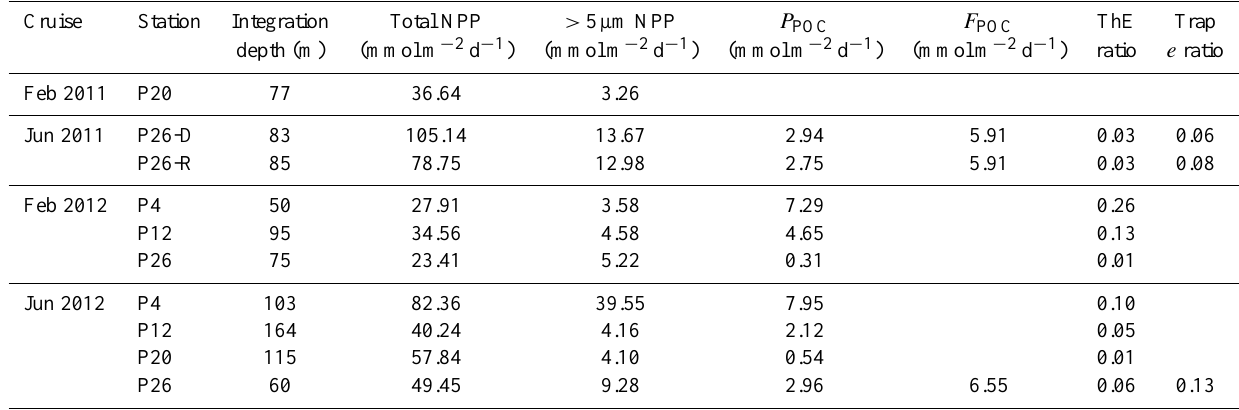
Table 3. Total net primary production (NPP) and > 5µm size-fractionated NPP determined from simulated in situ incubations. 234 Th- derived POC flux ( P POC ) and sediment trap POC flux ( F POC ) determined at the base of the photic zone and the corresponding ThE ratios ( P POC / NPP) and trap e ratios ( F POC / NPP). Stations P26-D and P26-R refer to sediment trap deployment and recover stations,